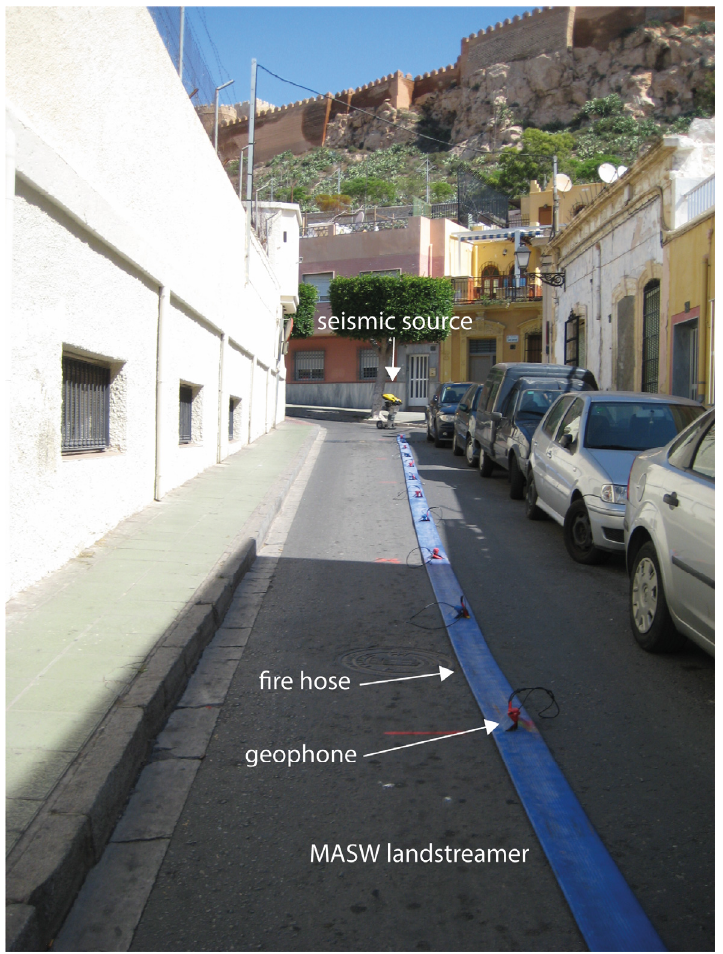
Figure 4. MASW landstreamer layout through Almeria city streets, with the seismic source at the back of the acquisition system.